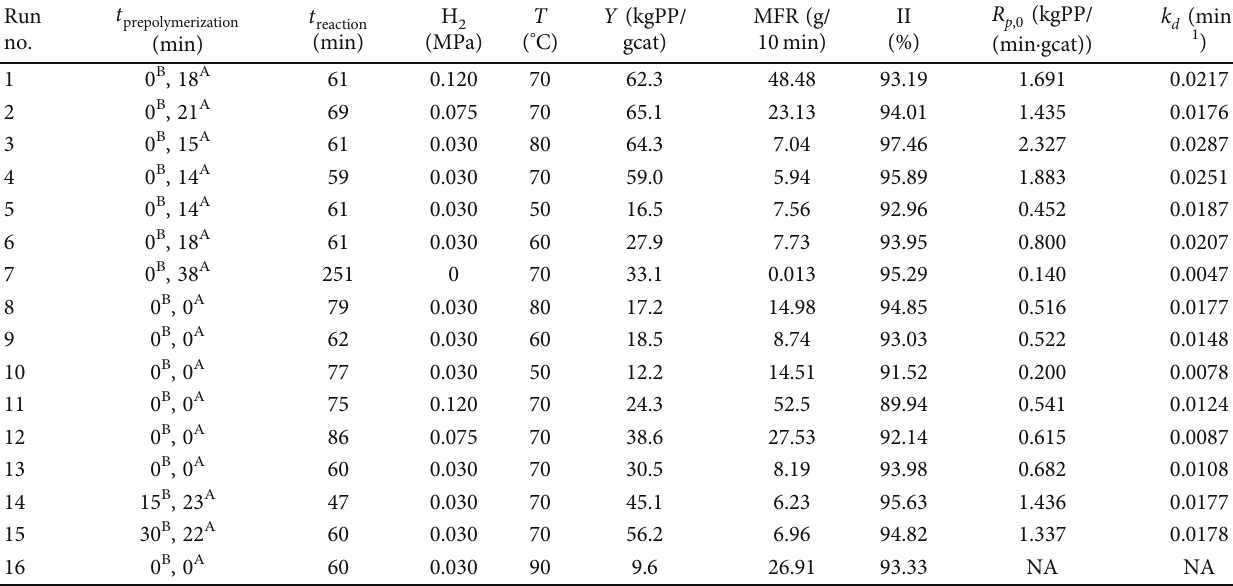
Table 2: Conditions and results of propylene bulk